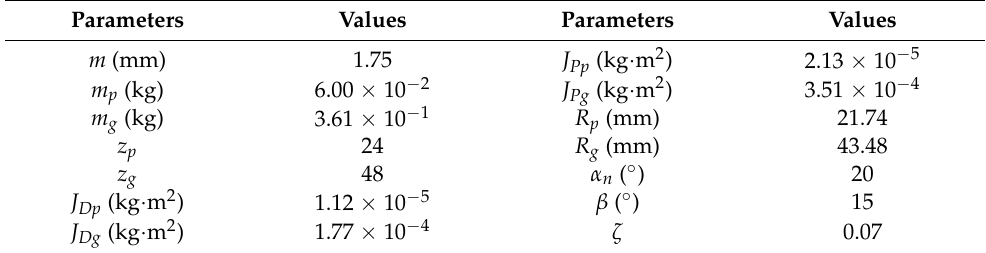
Table 3. Parameters of the helical gear